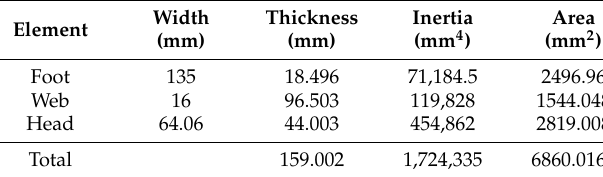
Figure 5. Dimensions of: ( a ) modeled rail; ( b ) standard 54E1 (UIC54) rail. The moment of inertia of the X -axis of the modeled rail, the horizontal axis, is shown in Table 1, where y (cid:48) is the distance between the centroid axis of the part of the body to the bottom edge of the body, y T (cid:48) is the distance between the centroid axis of the body and the bottom edge of the body, I x is the moment of inertia of the modeled rail, and d is the distance between y (cid:48) and y T (cid:48) . Table 1. Calculated parameters of the modified